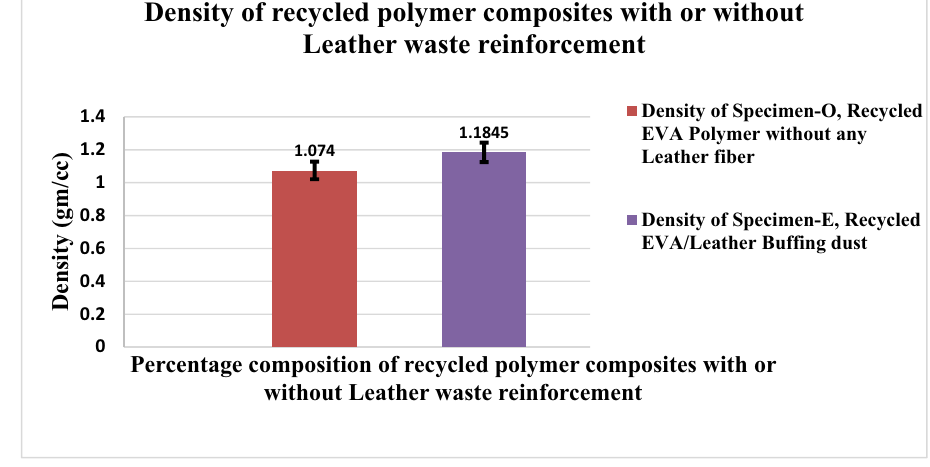
Figure 44: Comparison of density ( g/cm 3 ) of recycled EVA polymer composites with or without leather bu ffi ng dust.